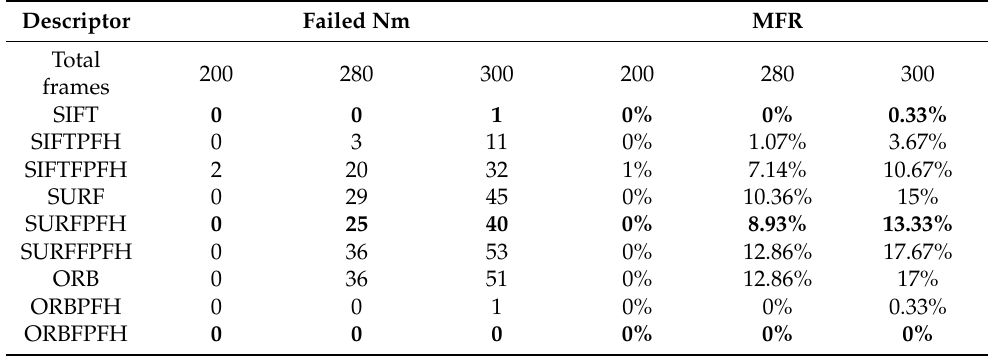
Table 3. Failure rate of feature matching in the YCB 0024 dataset.